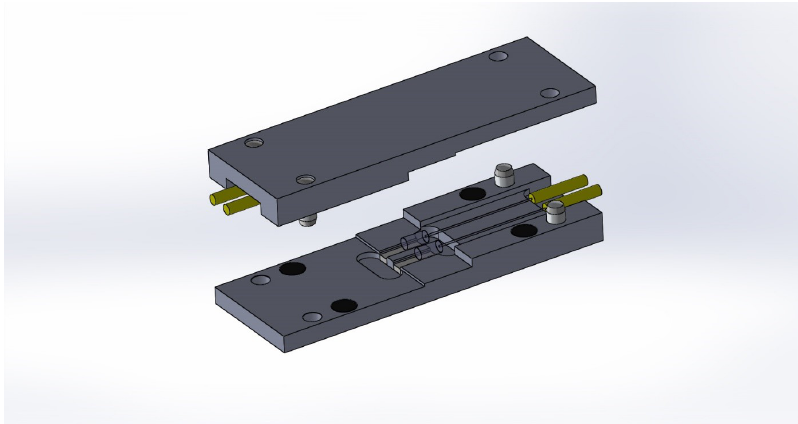
Figure 4. Design of the connector for an intelligent technical textile